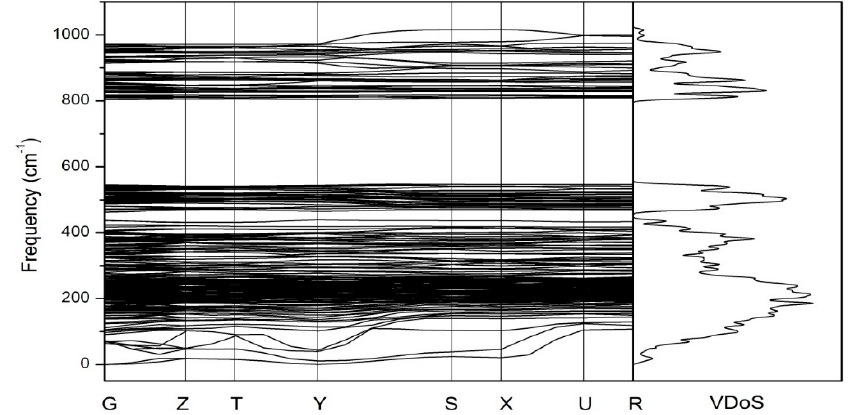
Figure 5. Phonon dispersions and vibrational density of the states (VDoS) of Ca 7 MgSi 4 O 16 -Bre ( V = 1382.18 Å 3 ).